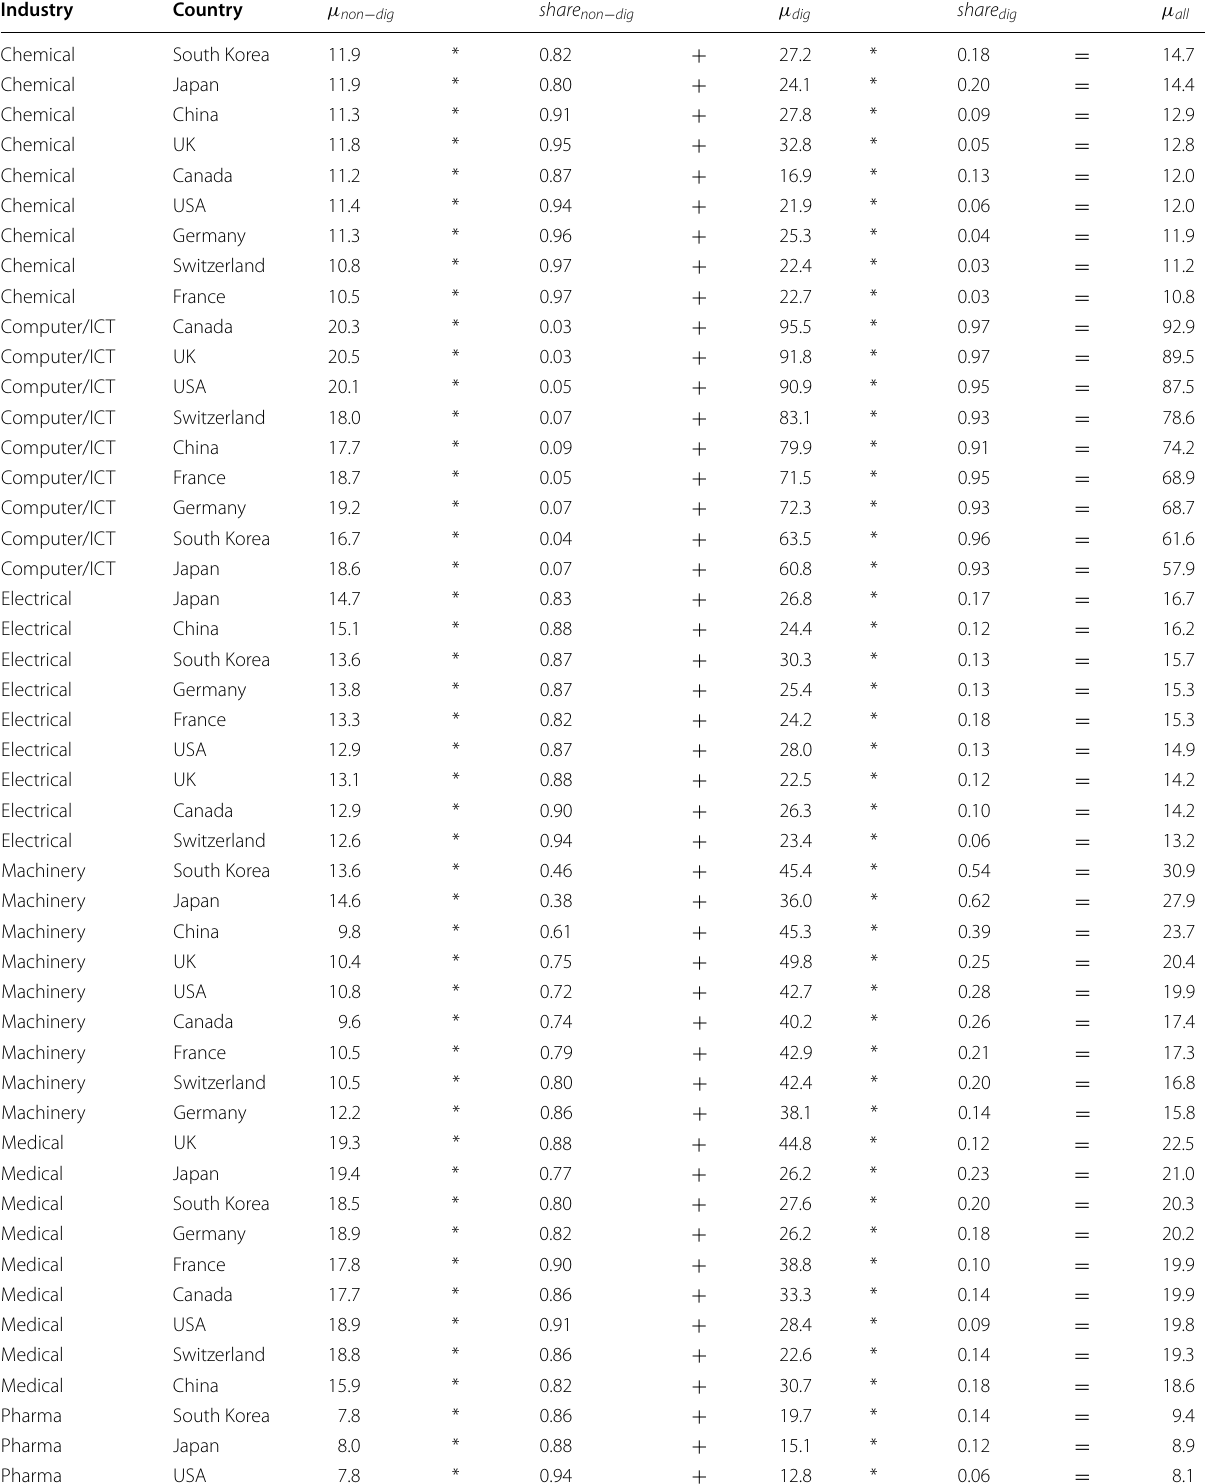
Table 16 Breakdown of the average technology improvement rate by digital, non-digital, and all patents for different countries and